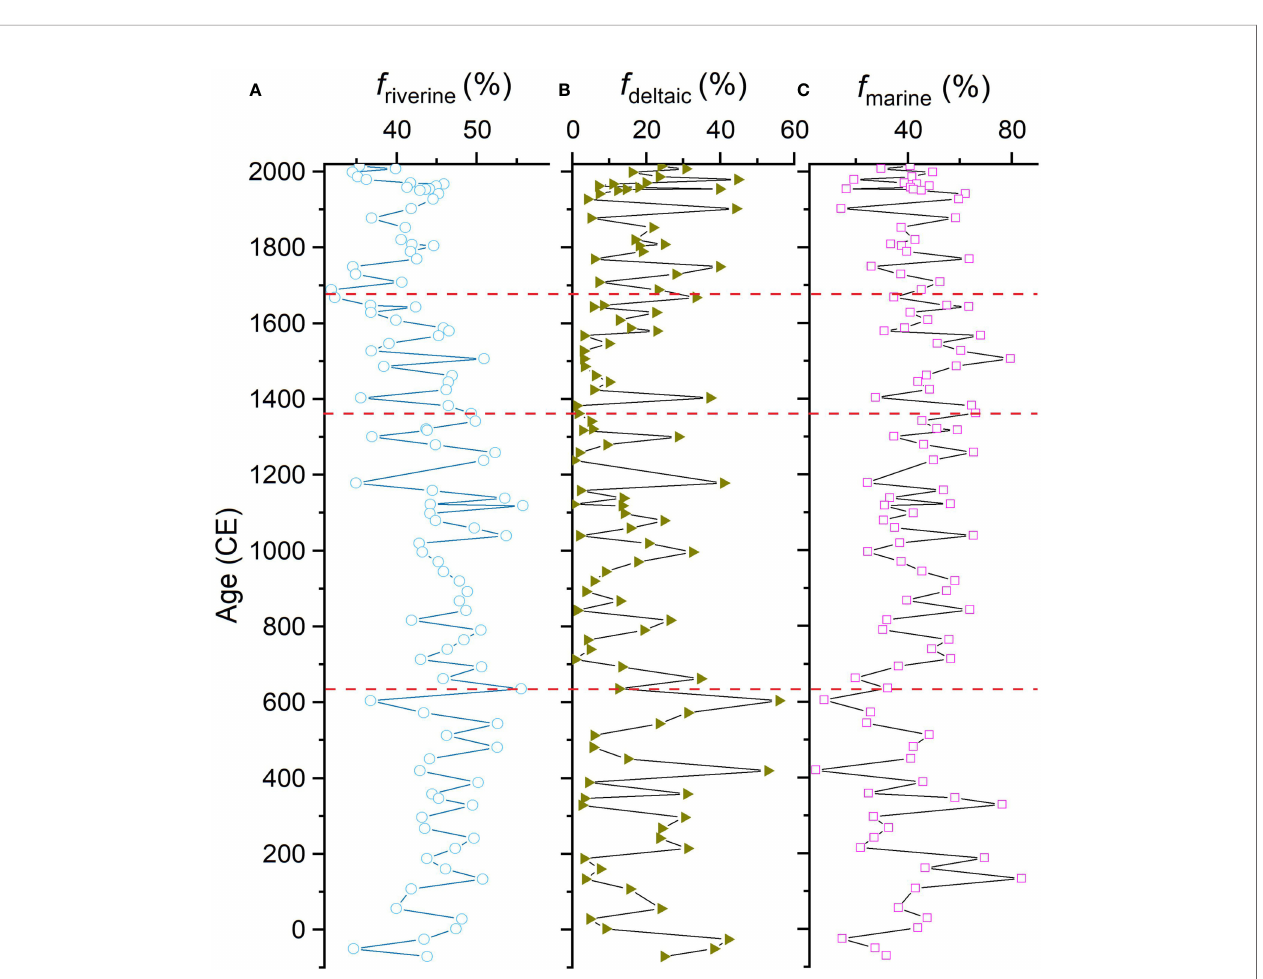
FIGURE 4 | Variations in sedimentary contributions (%) of riverine (A) , deltaic (B) , and marine (C) OC in Core C2. Dashed lines mark evolutionary stage divisions as discussed in Section